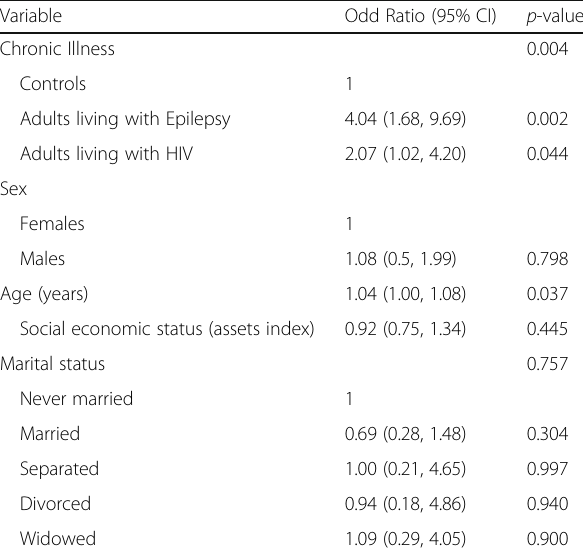
Table 3 Results from a multivariate logistic regression of psychological wellbeing and chronic illness status of the study